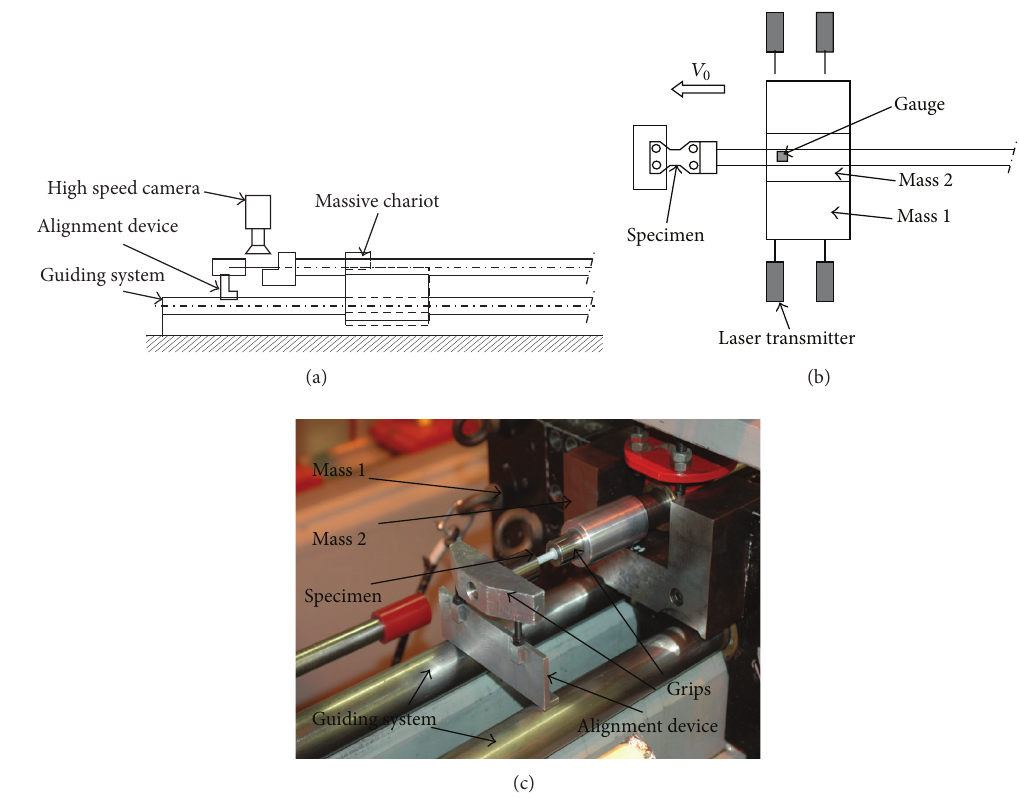
Figure 2: Crossbow system in tensile configuration: side view (a), top view (b), and overview (c).